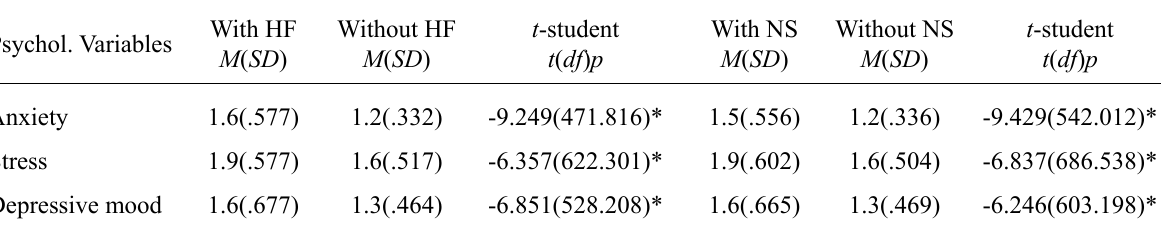
Table 4 Comparison of Women With and Without Hot Flushes (HF) and Night Sweats (NS) Regarding Levels of Stress, Anxiety and Depressive Mood Psychol.